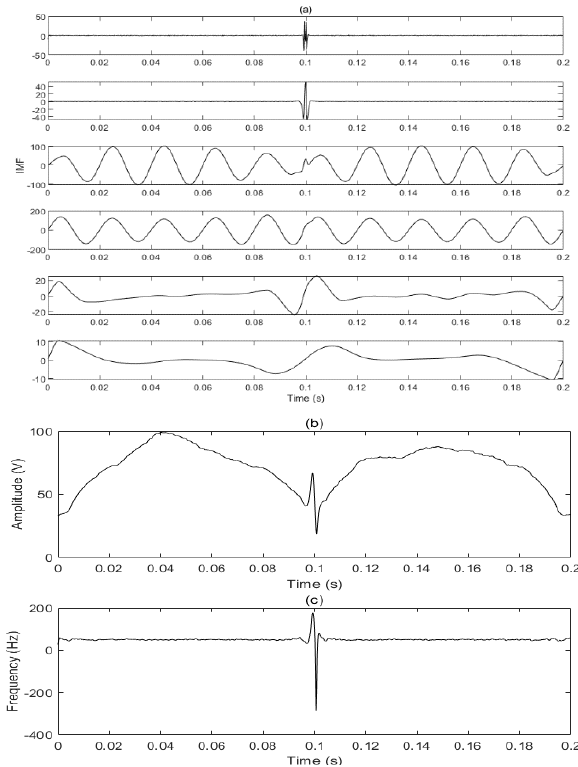
Figure 18. Oscillatory transient IMF components ( a ), amplitude ( b ), and frequency ( c ).